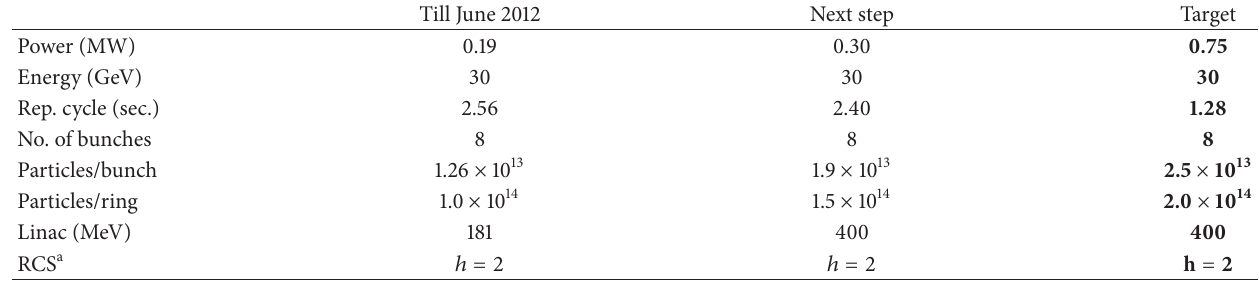
Table 4: MR power improvement scenario.